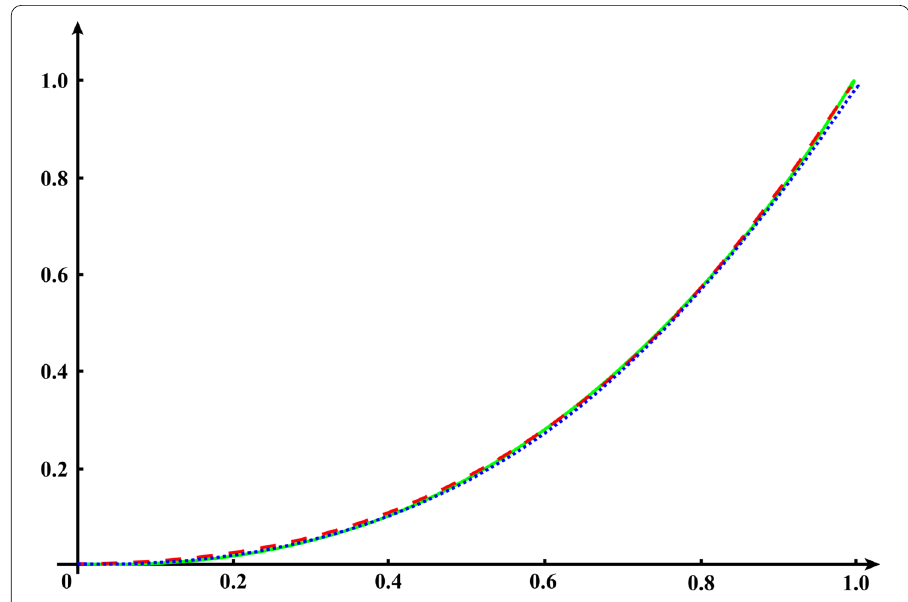
Figure 1 Comparison of solutions. Exact solution (green), DJIM-solution (blue) and ADM-solution (red)